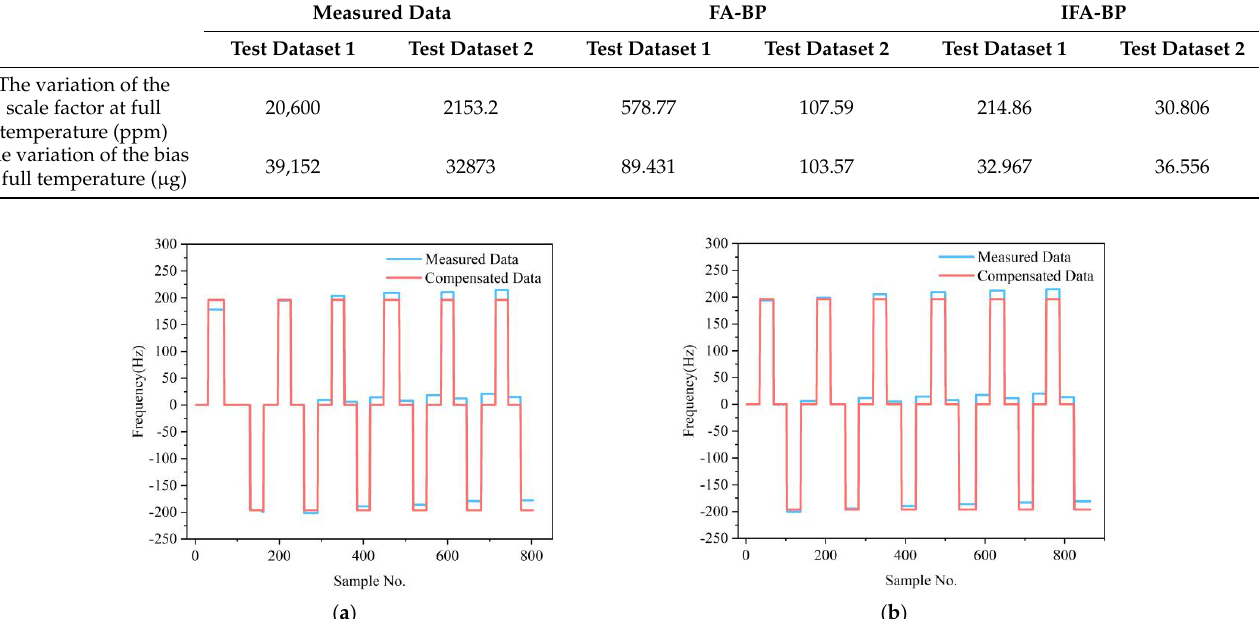
Table 2. The variation of scale factor and bias at full temperature before and after compensation.